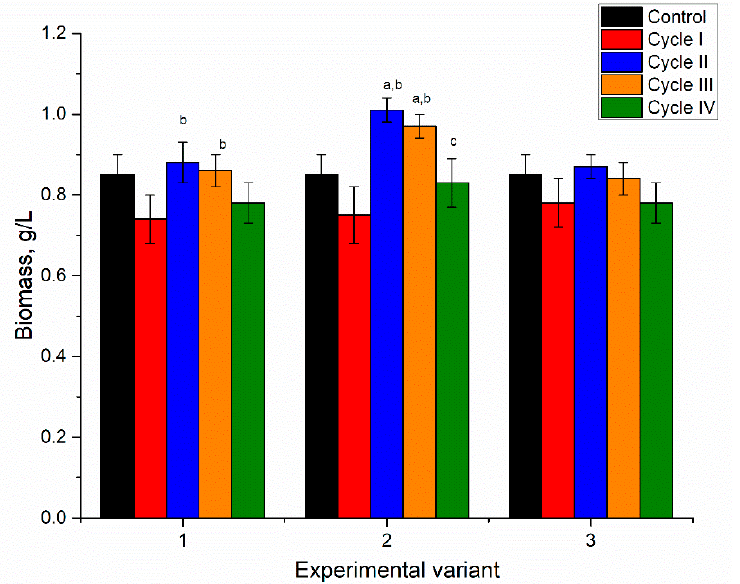
Figure 8. The amount of biomass in spirulina during its repeated cultivation in the medium containing metal ions at concentrations: nickel 2.5–10 mg/L, copper 0.5–1 mg/L, strontium—1–5 mg/L, and zinc—0.5–2 mg/L. a: p < 0.001 for the difference between experimental and control samples; b: p < 0.001 for the difference from the first cycle; c: p < 0.001 for the difference from the second cycle.